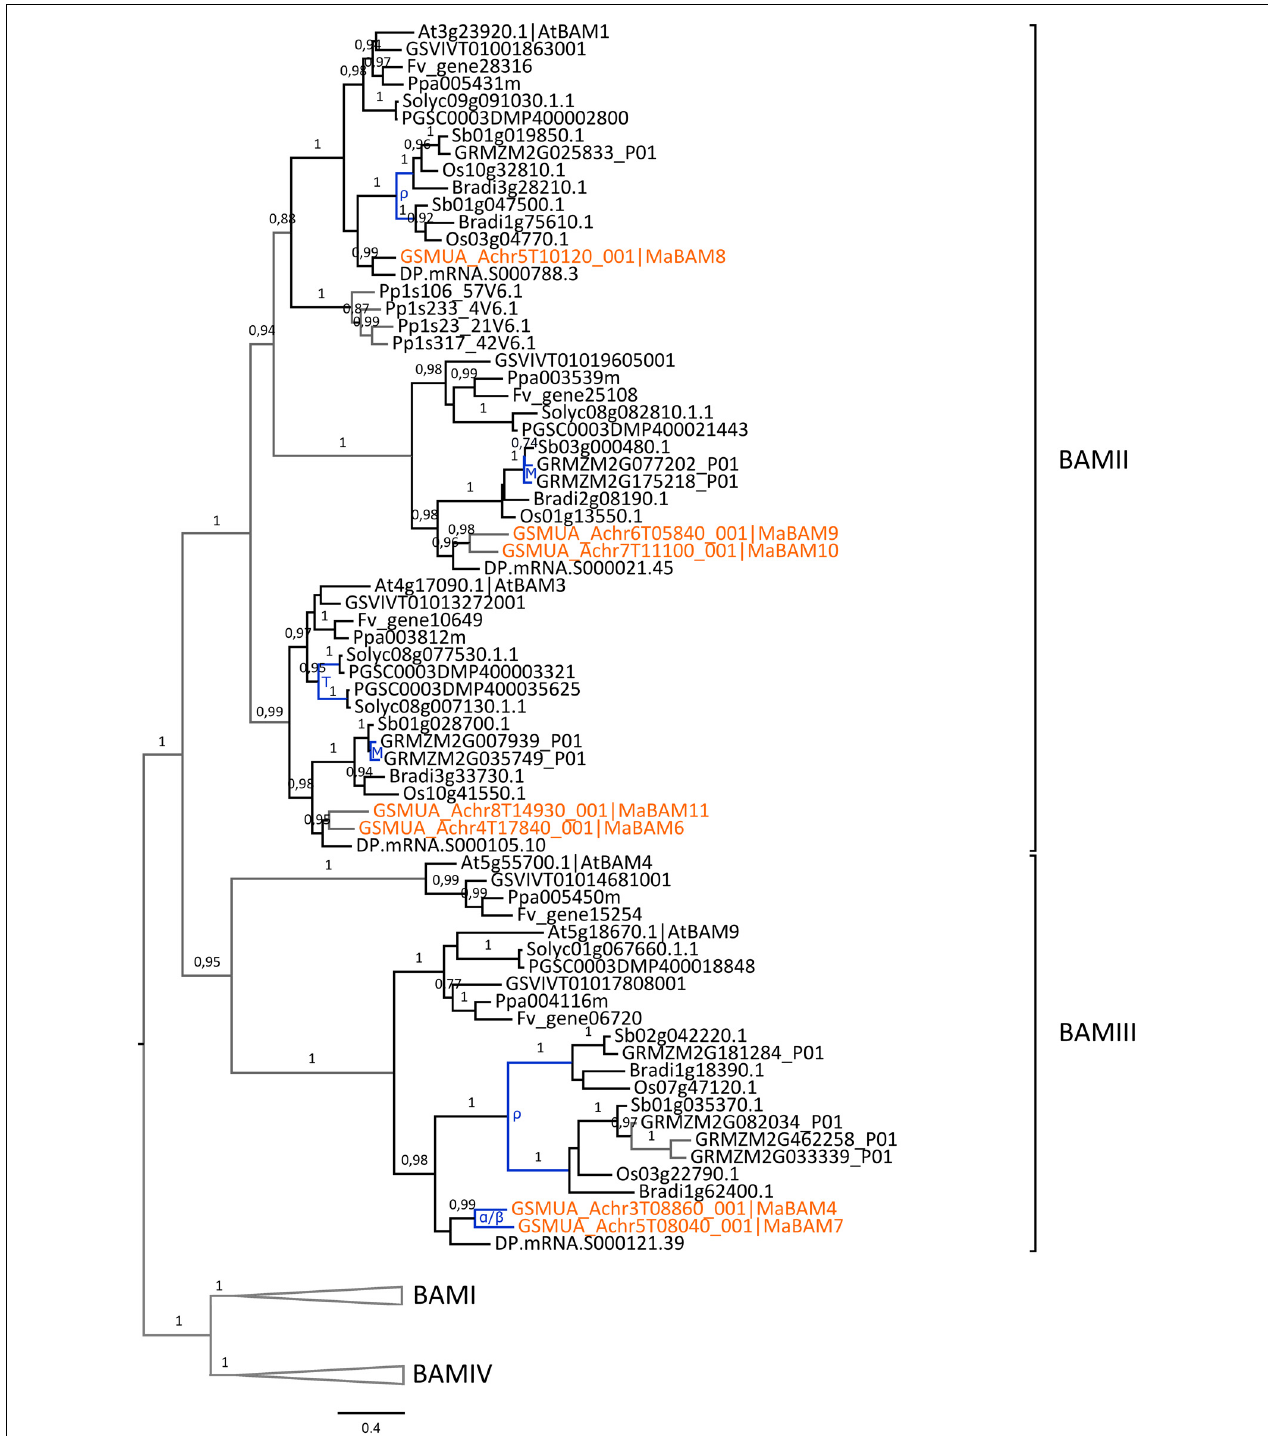
FIGURE 7 | Phylogenetic analysis of the BAM family. The maximum likelihood tree of BAM predicted proteins was rooted on midpoint. BAMI and BAMIV sequences are collapsed from the original tree (Supplementary Figure S3). Supports > 0.70 (aLRT statistics with SH–like procedure) are indicated. Physcomitrella patens (Pp), grapevine (GSVIV), tomato (Solyc), potato (PGSC), woodland strawberry (Fv), Arabidopsis (At), peach (Ppa), Brachypodium (Bradi), rice (Os), maize (GRMZM), sorghum (Sb), date palm (DP) and banana (GSMUA) identifiers are indicated (in brown for banana). Branches are colored according to gene duplication modes: WGD (blue) and unknown (gray). Black branches correspond to speciation events. WGD events identified using reconstructed ancestral blocks are indicated (blue letters). The scale bar corresponds to estimated amino acid substitutions per site. Sequences were grouped using the tree topology and a previous classification (Fulton et al.,